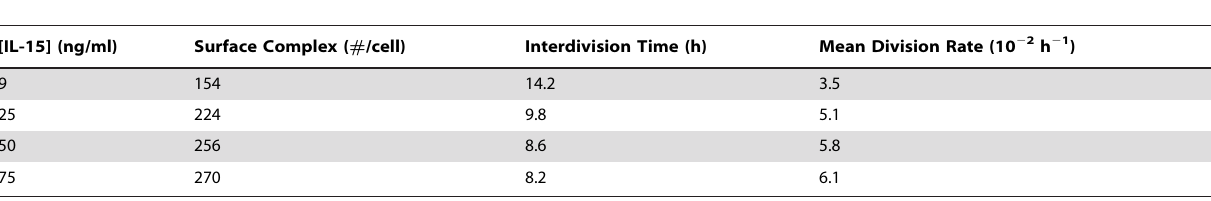
Figure 7. Formation of high affinity receptor-ligand complexes facilitates exponential expansion of dividing NK cells. A . The total steady state cell surface IL-15/IL-15R complex numbers in the high affinity binding model stimulate an exponential proliferative response, illustrated by plotting the fraction of maximal response vs. total C s at the corresponding IL-15 concentrations. B . The maximum number of divisions calculated from the time elapsed since recruitment to cell division by the interdivision time for four different IL-15 concentrations. Solid lines represent model predictions, and filled circles represent the maximum detectable number of NK cell divisions obtained from independent experiments (9 ng/ml n=3, 25 ng/ml n=4, 50 ng/ml n=2, and 75 ng/ml n=3). The quality of prediction is represented by the normalized root mean squared deviation (NRMSD). The NRMSD of model prediction vs. experimental data are shown as percentages in the upper left of each graph. For reference, linear regression was performed for all four sets of experimental data, and the NRMSD values of the linear regressions were 9% (9 ng/ml), 10% (25 ng/ml), 14% (50 ng/ml), and 12% (75 ng/ml). C . Population mean division rate is estimated from the interdivision time for four IL-15 concentrations. White bars represent model predictions while black bars represent experimental data from the analysis of NK cell populations in 2–4 independent experiments. doi:10.1371/journal.pcbi.1003222.g007 Table 3. Estimates of NK cell interdivision times and division